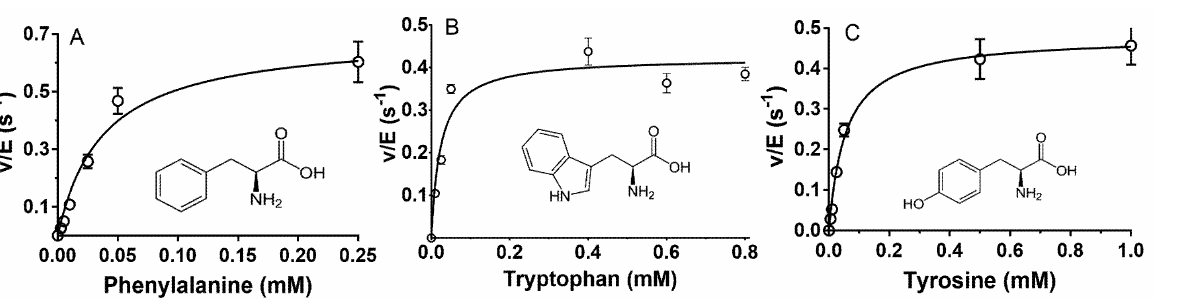
Figure 3. Steady-state kinetic analysis of the reactions of select amino acid substrates with P. luteoviolacea CPMOR-1 LAAO. The analysis of the data is shown for ( A ) Leucine, ( B ) Methionine, ( C ) Glutamine, ( D ) Isoleucine, ( E ) Valine and ( F ) Glutamic acid. The lines are the fits of the data to Equation (1). Data points are the average of three replicates. The structures of each amino acid are shown with each plot.